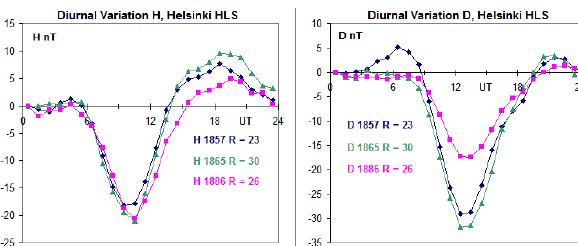
Figure A5. Diurnal variation of H (left) and of D (right) at Helsinki for 3 years with a SIDC sunspot number of ∼ 25. It is very hard to escape the conclusion that the range of D for the year 1886 is too small compared to the other years with a similar sunspot number as the range of H is about the same for the 3 years shown. Detailed analysis shows that the problem exists from October 1885 to May 1887. In August 2003 we emailed Nevanlinna alerting him to this problem, but, unfortunately, no corrective action resulted from this. It is now clear that scale-value problems exist for both the H component and for the declination and that corrective action is mandatory before use of the Helsinki data.